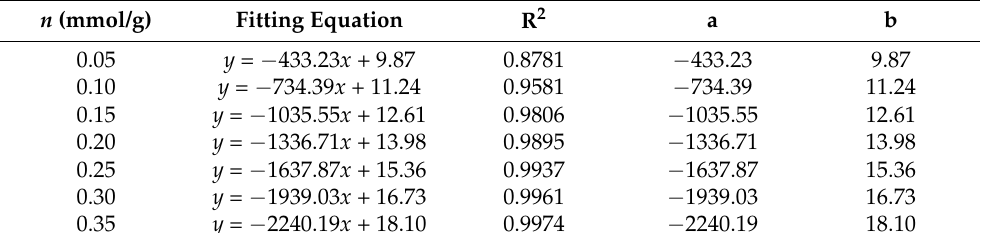
Figure 14. The relationship between ln P and 1/ T under different given adsorption amount. Table 7. The results of fitting ln P and 1/ T under different given adsorption amount.